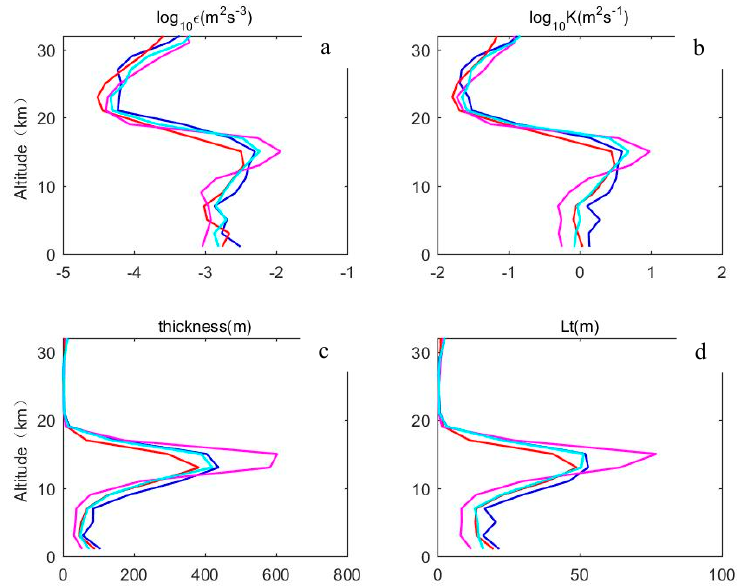
Figure 10. Seasonal vertical profiles of the median values of ( a ) the logarithm of ε , ( b ) the logarithm of K , ( c ) turbulent thickness, ( d ) Thorpe length (blue: January–March; red: April–June; magenta: July–September; cyan: October–December).